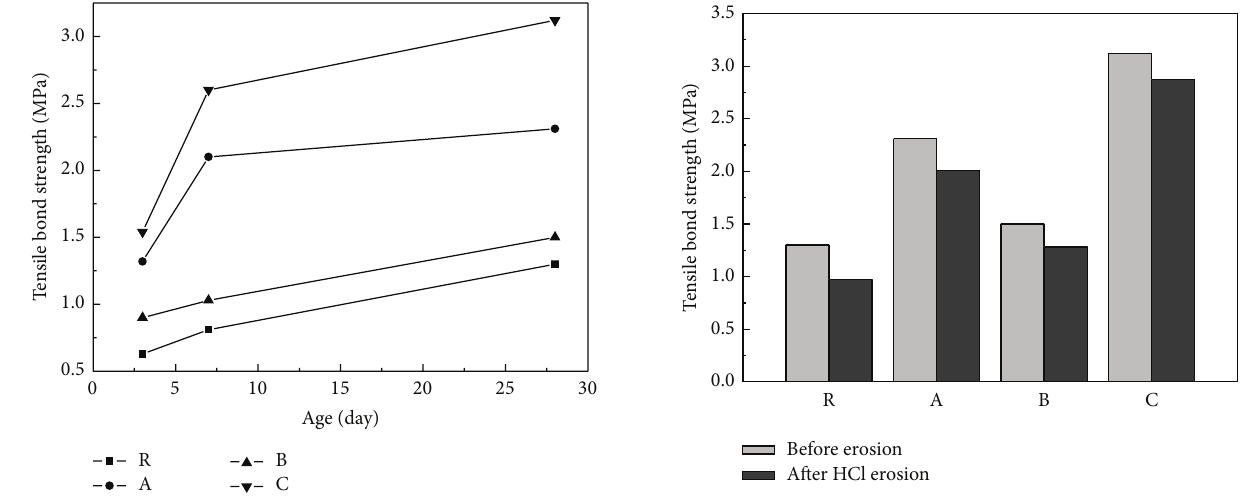
Figure 1: Relationship of tensile bond strength of repair mortars with age.